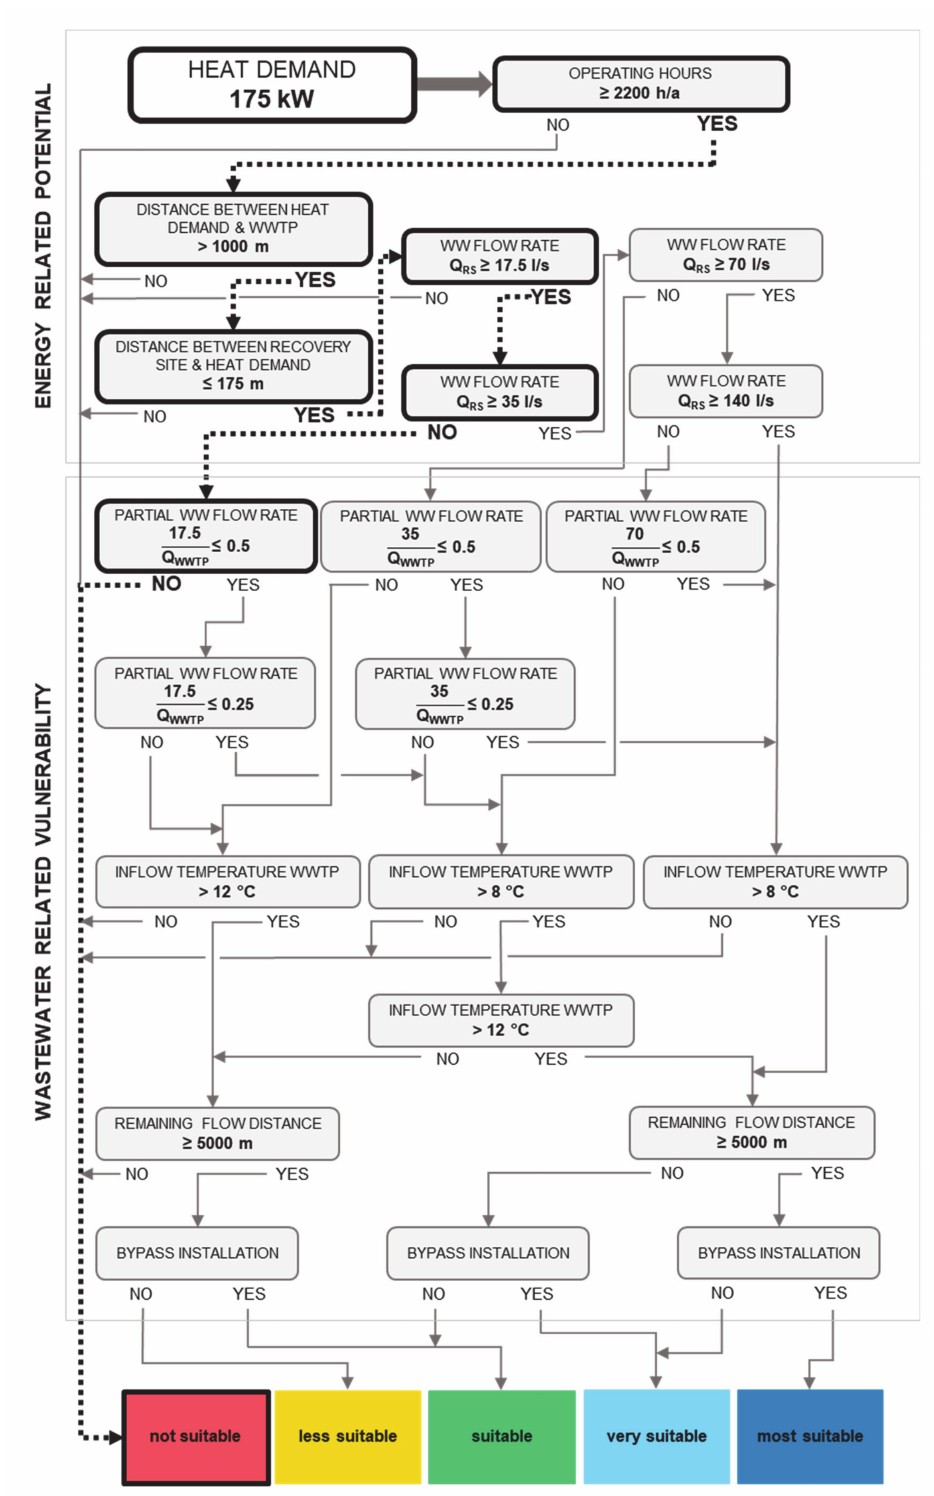
Figure 6. Pre-assessment process for heat recovery site M2 for an intended heat supply of 175 kW (own representation, based on